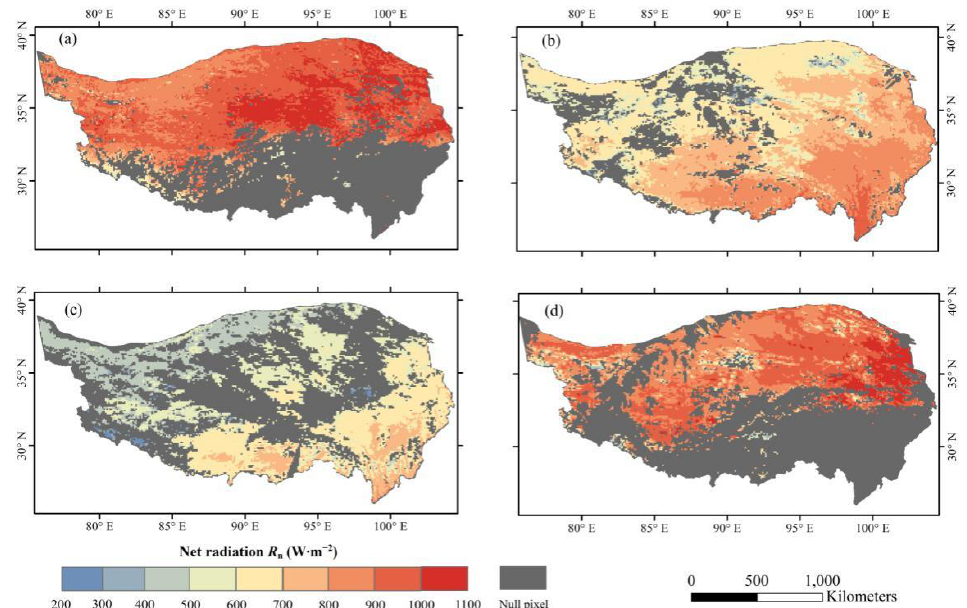
Figure 6. Spatial distribution of net radiation R n at 10:30 local time on July 24 ( a ) and October 25 ( b ) in 2014, and January 21 ( c ) and April 26 ( d ) in 2015. Note: R n stands for net radiation. The unit is W / m − 2 . Remote Sens. 2020 , 12 , 501